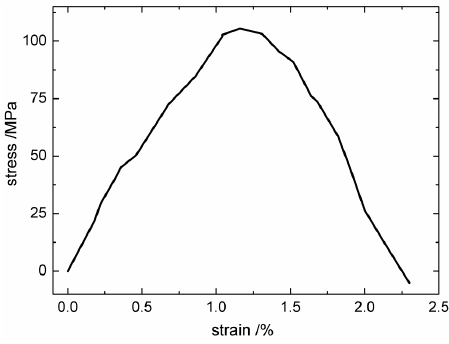
Figure 15. The tangential shear stress–strain curve of the isotropic pyrolysis carbon (IPyC) matrix.